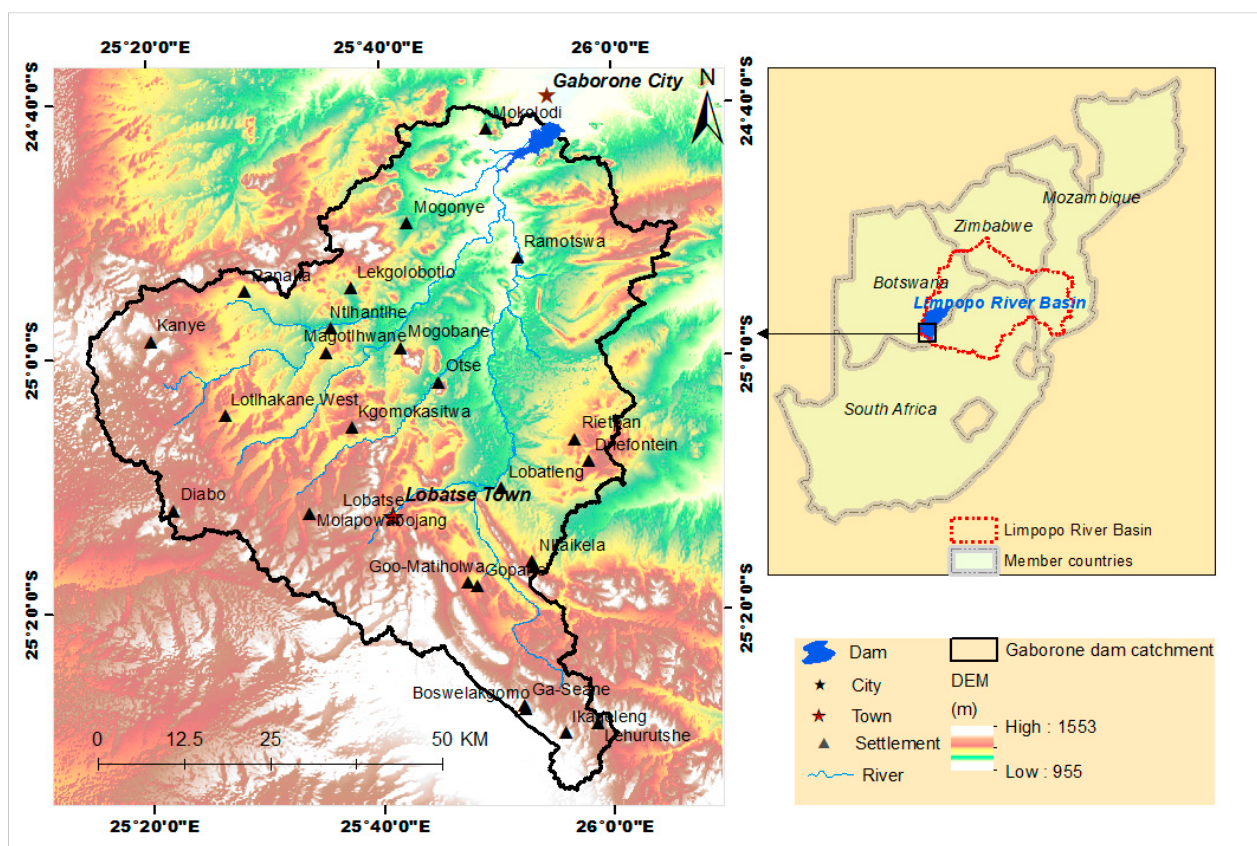
Figure 1. Locational map of the study area.